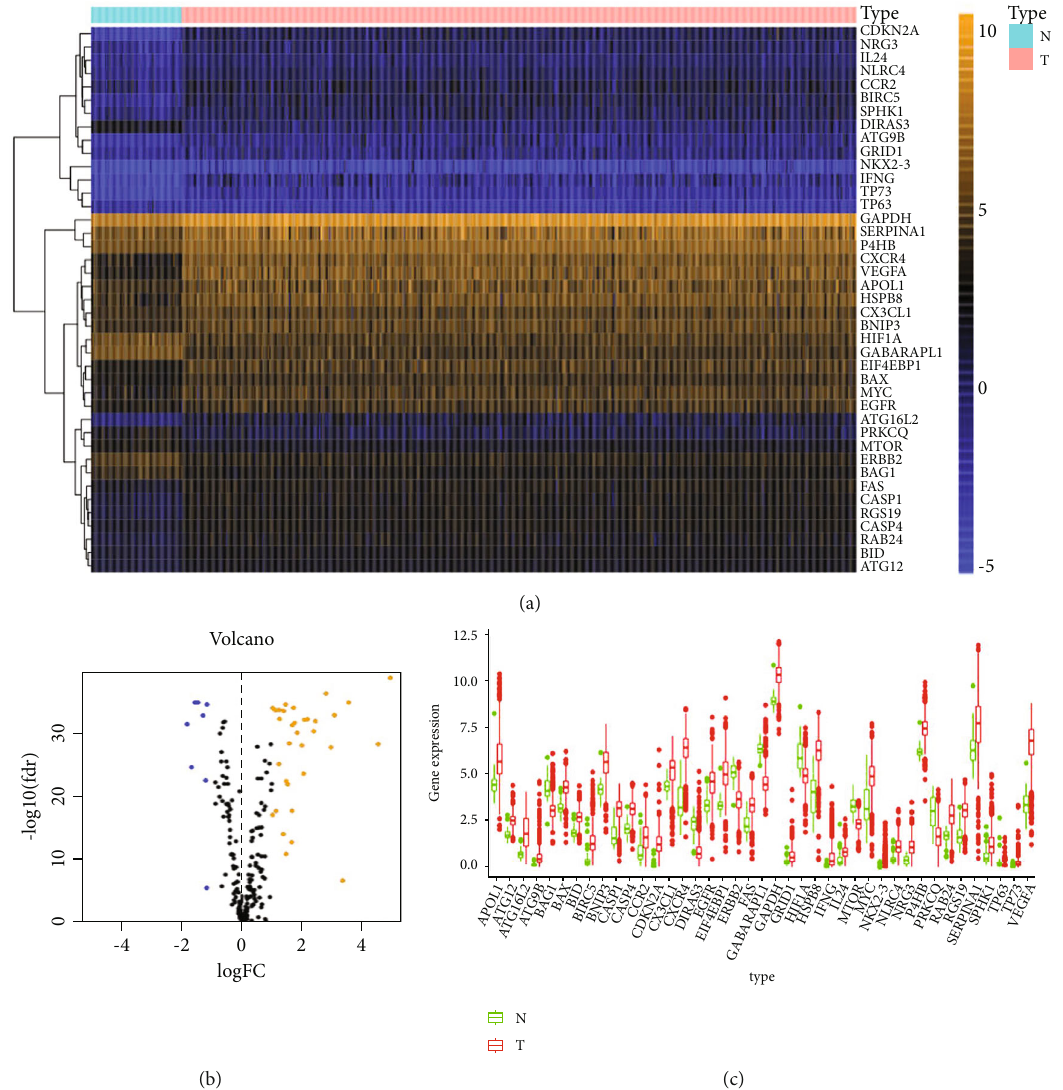
Figure 1: The autophagy-related genes of di ff erential expression. (a) Heatmap of the autophagy-related genes of di ff erential expression (ARG). N was tantamount to nontumor tissues; T was tantamount to tumor tissues. (b) Volcano plot on the ARGs of di ff erential expressions. Orange dots indicated the ones of high expression whereas the blues were for the low expressions. (c) The boxplot for the ARGs of di ff erential expression. Red and green regions separately represented tumor tissues and normal